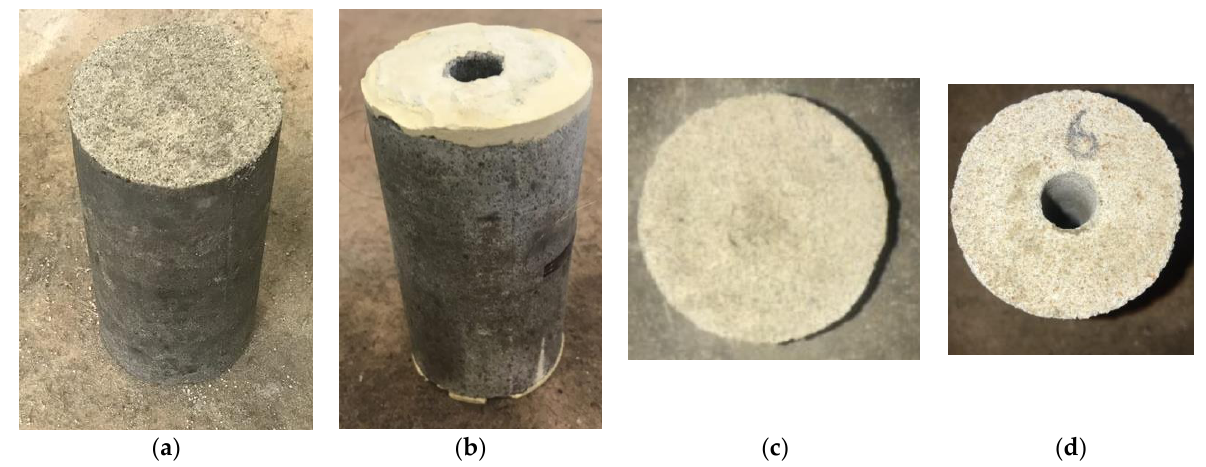
Figure 3. ( a ) Cylinder sample side view, ( b ) TWHC sample side view, ( c ) cylinder sample top view, ( d ) TWHC sample top view.